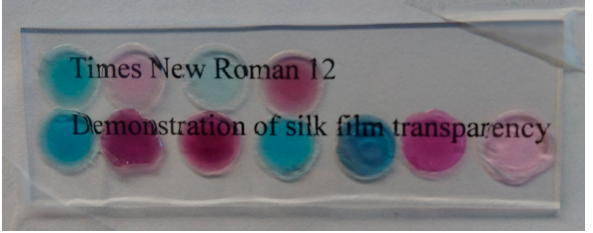
Figure 5. Photograph of selected silk-dye-patches (red for neutral red and blue for thionine) on a glass slide. Behind the patches and the glass slides are lines of text to illustrate the transparency of the patches. For convenience, the patches were wetted to adhere on the glass slide.